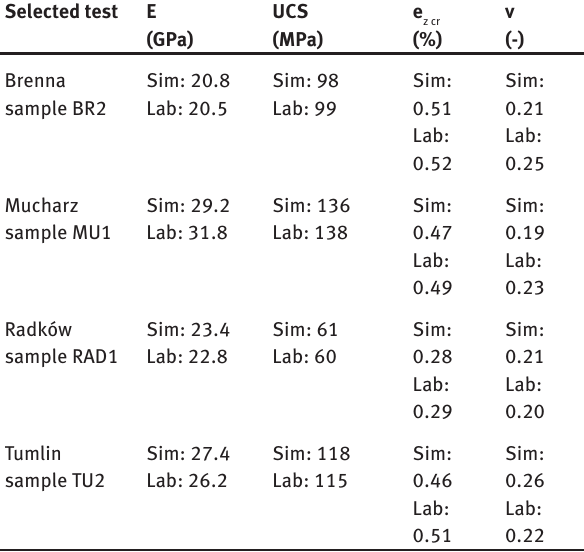
Table 4: Comparison between crucial macroscopic parameters used for model calibration. ‘Sim’ stands for simulation result and ‘lab’ stands for result from the laboratory